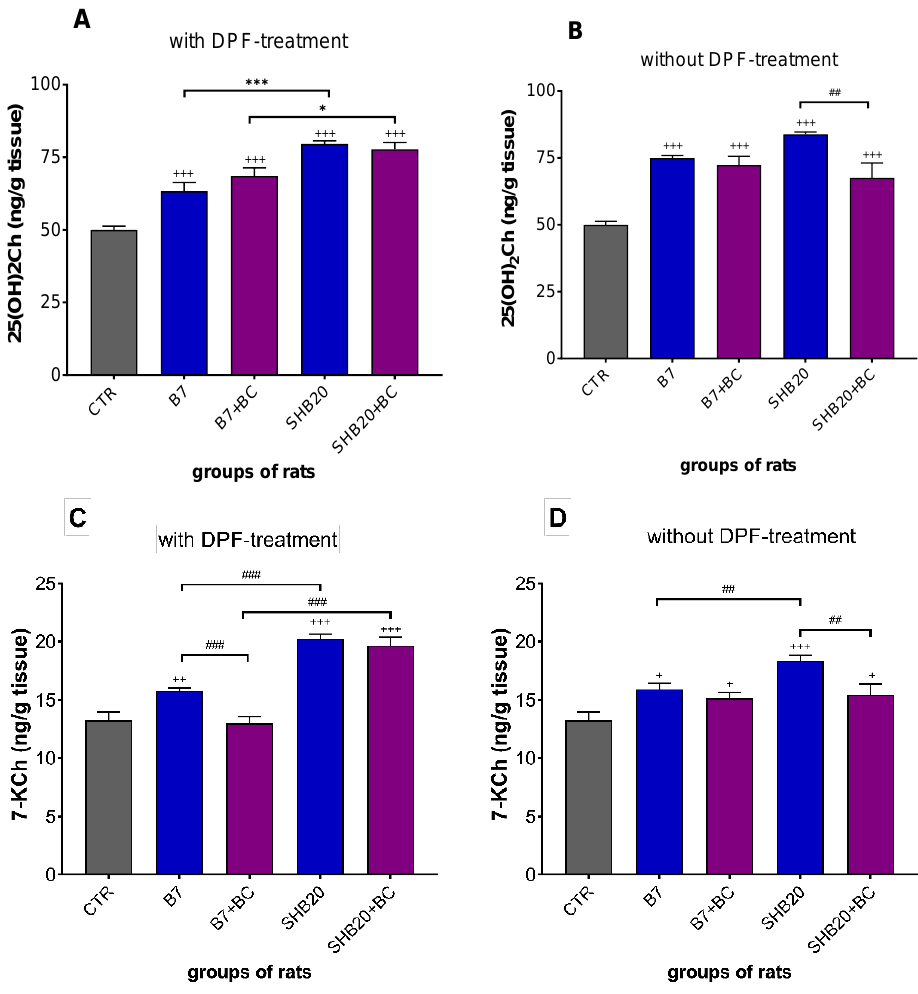
Figure 6. The concentration of 25-dihydroxycholesterol (25(OH)2Ch) ( A , B ) and 7-ketocholesterol (7-KCh) ( C , D ) in the testes of rats exposed to DEE from B7 and SHB20 biofuels with and without DPF-treatment and with or without blackcurrant pomace supplementation (BC) for 28 days. Data are expressed as mean ± SEM. # — Statistically significant difference between normal and blackcurrant pomace supplemented diet, ## p < 0.01; ### p < 0.001; * — Statistically significant difference between B7 and SHB20 DEE, * p < 0.05; *** p < 0.001; + — Statistically significant difference from the control group (CTR), + p < 0.05; ++ p < 0.01; +++ p < 0.001, one- way ANOVA with Duncan’s post hoc test.